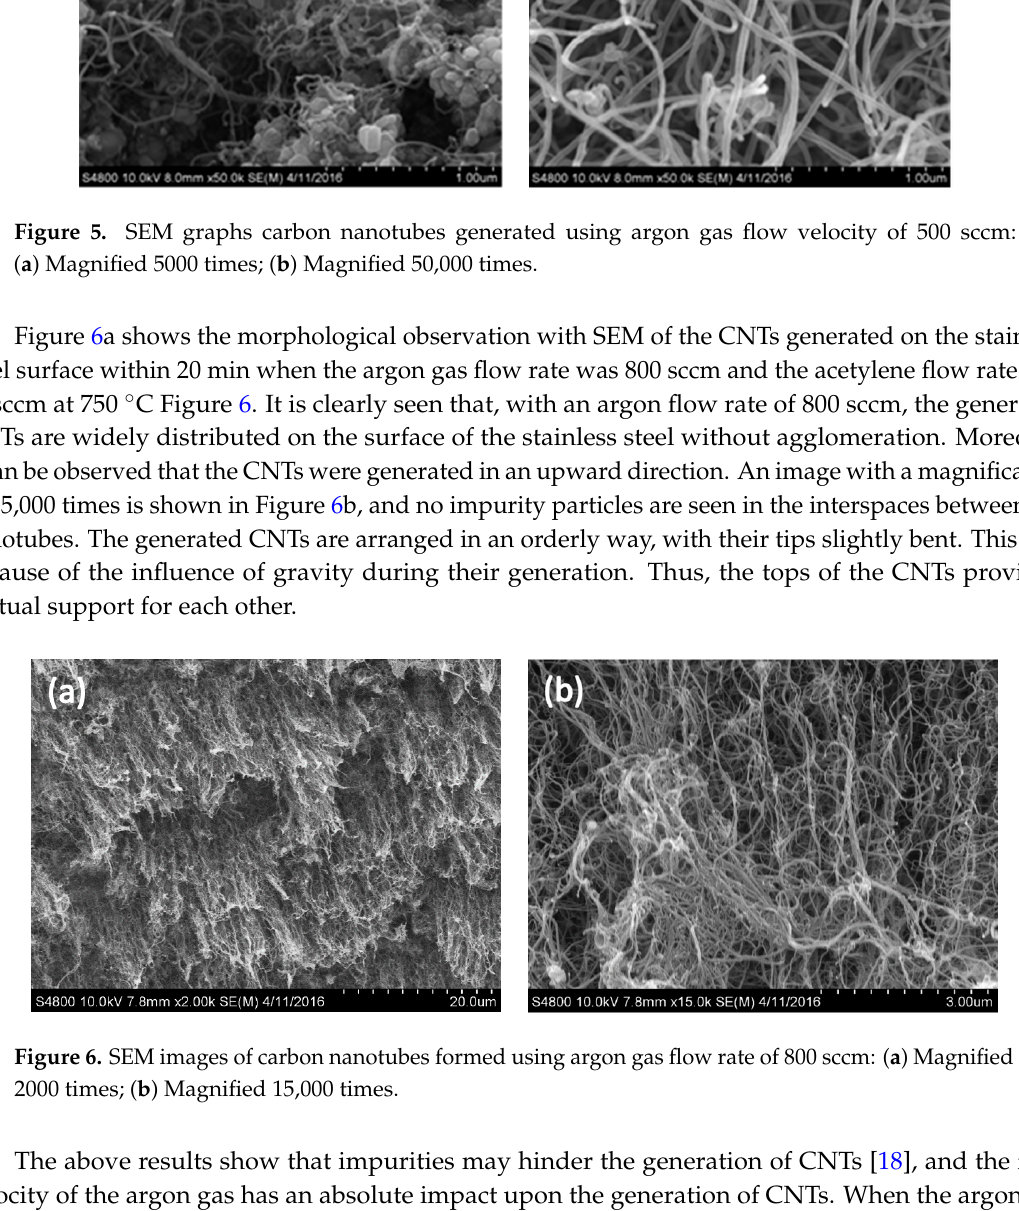
Figure 6. SEM images of carbon nanotubes formed using argon gas flow rate of 800 sccm: ( a ) Magnified 2000 times; ( b ) Magnified 15,000 times.